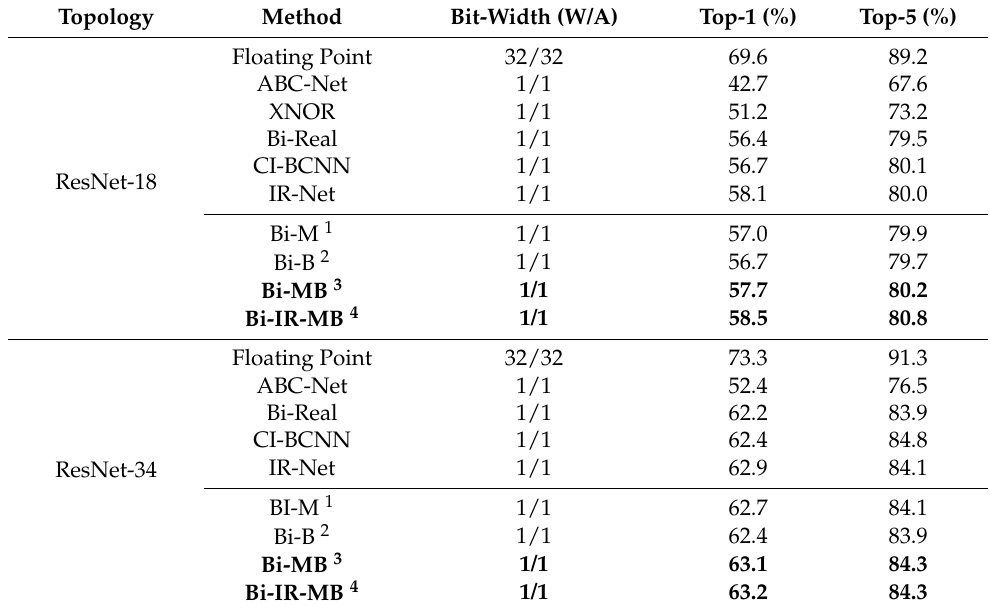
Table 5. Performance comparison with state-of-the-art (SOTA) methods on the ImageNet. The best results are highlighted in bold.